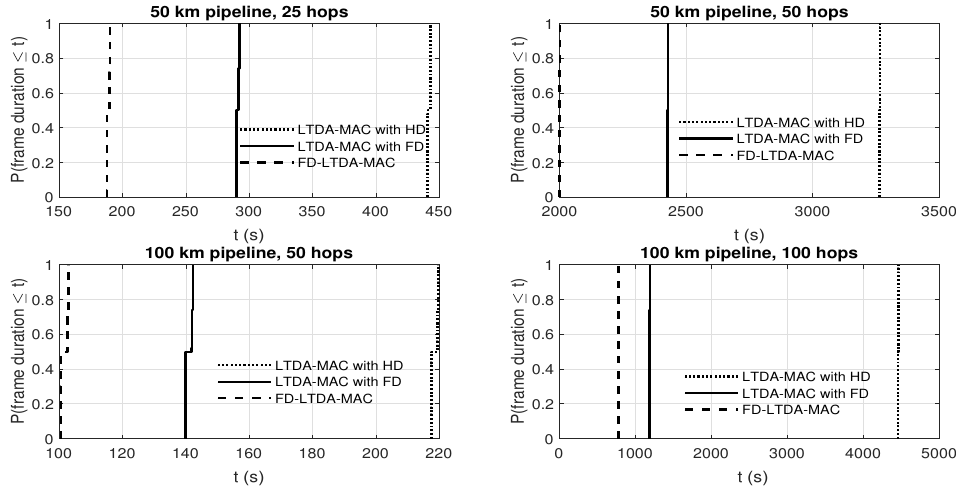
Figure 12. Frame duration cdfs of LTDA-MAC with HD nodes, LTDA-MAC with FD nodes and FD-LTDA-MAC for medium scale